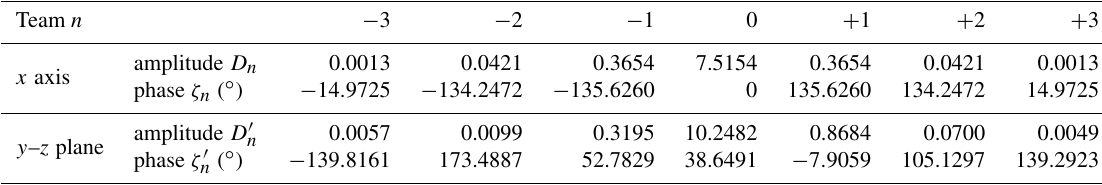
Table 6. The amplitude and phase of the prescribed position.